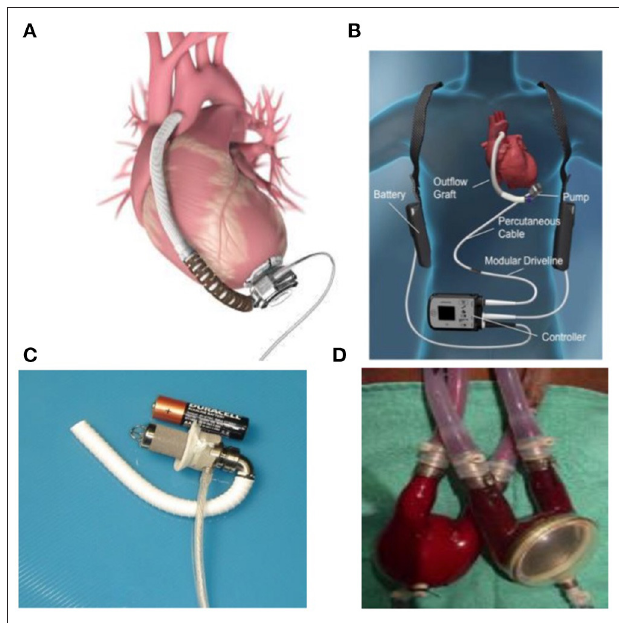
EFFECTS OF THE BLOOD-SURFACE INTERFACE ON